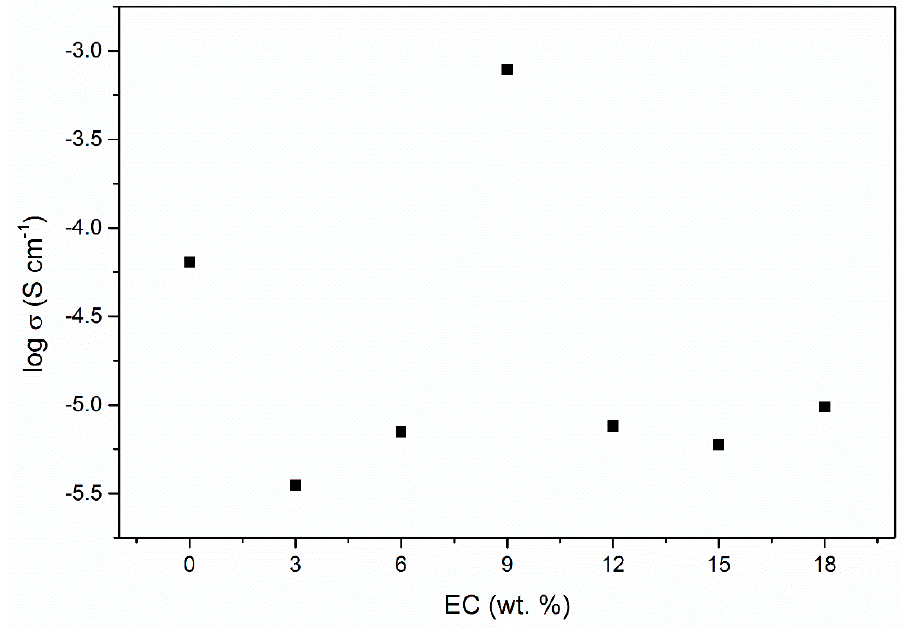
Figure 3. Log conductivity of PUA electrolyte at varied concentrations of EC plasticizer.